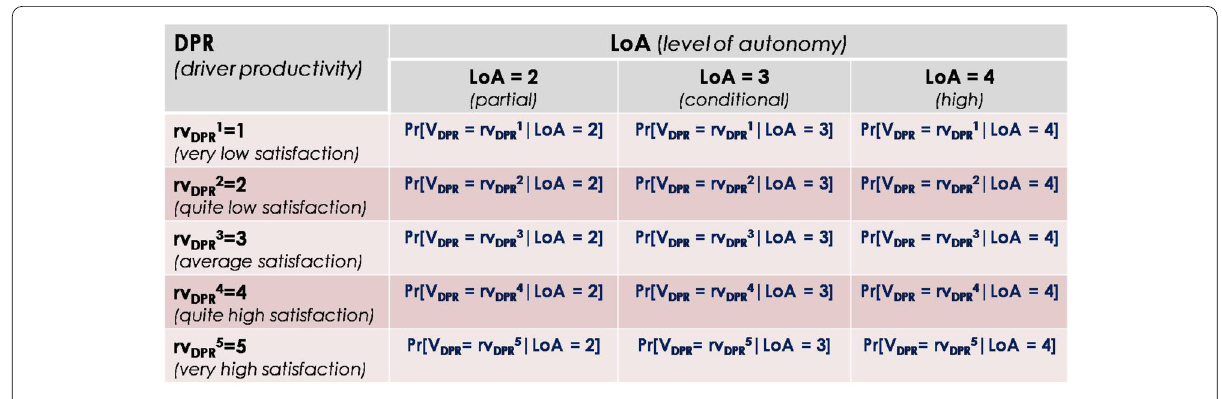
Figure 4 Structure of a CPT focusing on “DPR” variable of